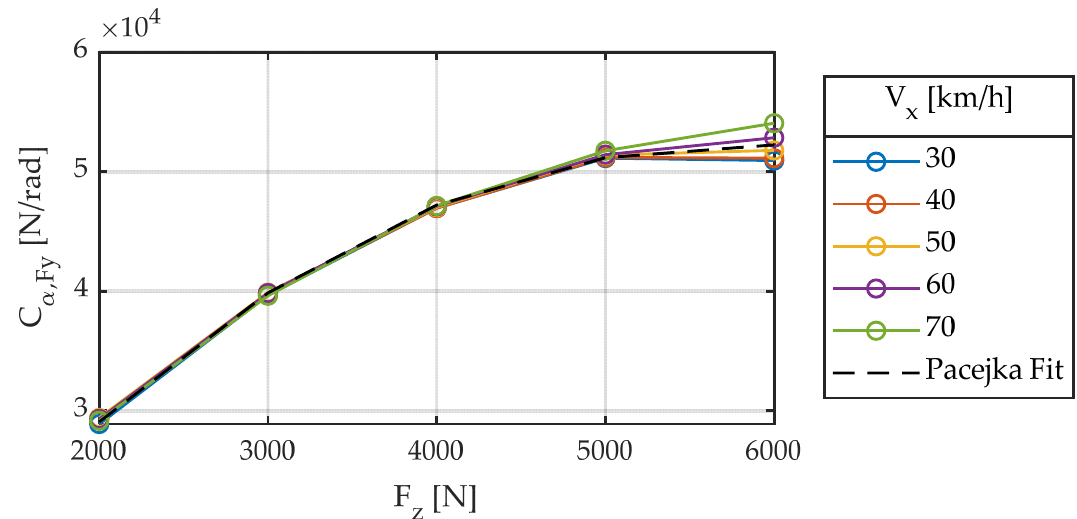
Figure 9. Cornering stiffness for different longitudinal speeds. Slip angle sweep ± 2 ° . Frequency 1.0 Hz.